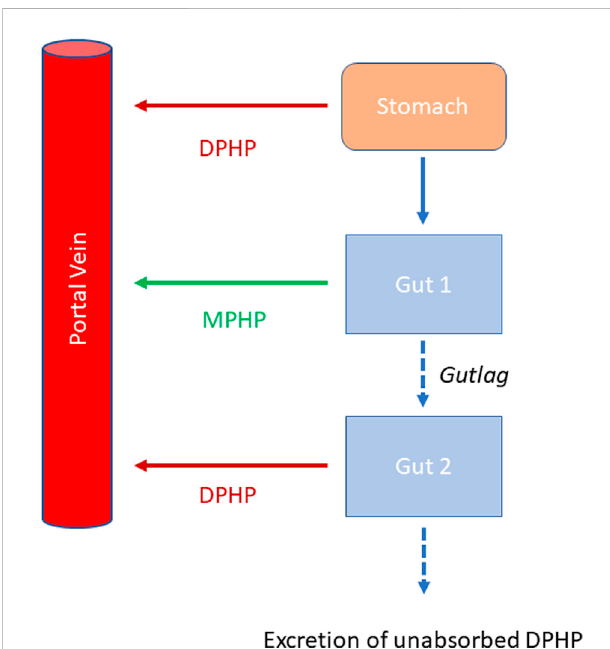
FIGURE 3 Schema of the modi fi ed stomach and gut sub model showing the introduction of DPHP into the stomach via oral administration, transport of DPHP from the stomach to the GI tract with metabolism of DPHP to